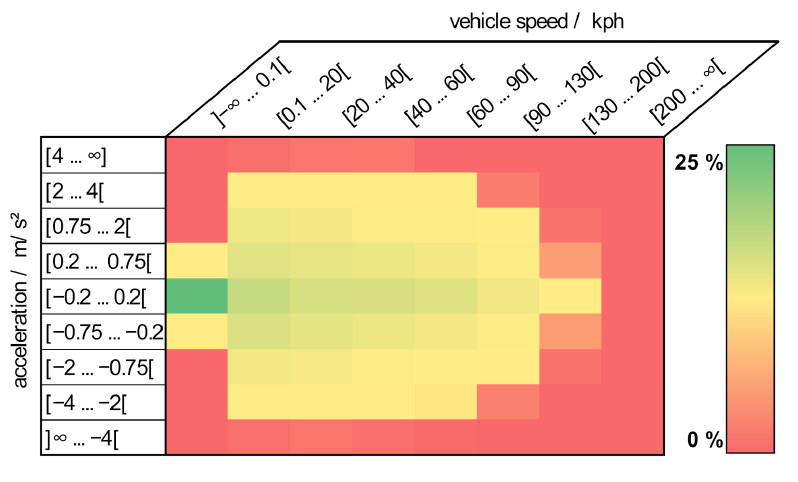
Figure 2. Exemplary heat map for customer